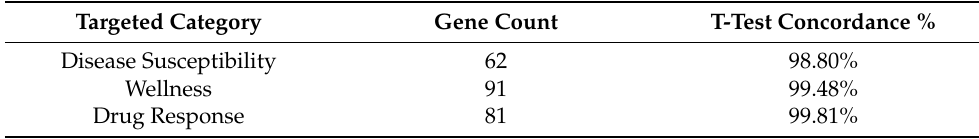
Table 6. Sample Allele Frequency vs. Population Allele